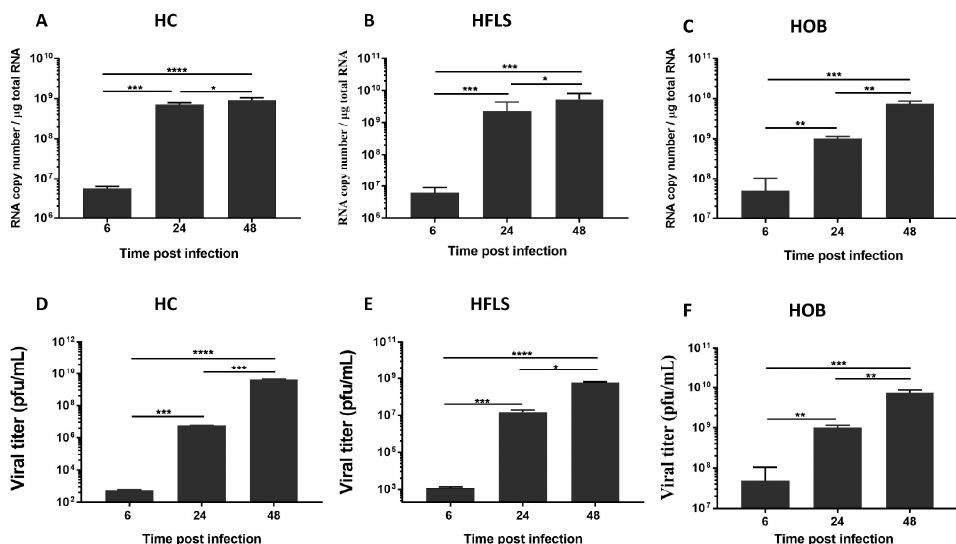
Figure 1. Human chondrocytes (HC), fibroblast-like synoviocytes (HFLS) and osteoblasts (HOB) are permissive to Mayaro virus (MAYV) infection. Cells were infected with MAYV at a multiplicity of infection (MOI) of 1. Viral RNA expression was then measured at 6, 24 and 48 h post-infection using real-time polymerase chain reaction (PCR) ( A – C ). Plaque assay analysis of culture supernatants of MAYV-infected cells were used to detect infectious viral particles ( D – F ). Experiments were performed three times each in triplicate (error bars represent standard errors of the means [SEM]). Comparisons between the indicated time point post infection were performed using one-way analysis of variance (ANOVA) and Tukey’s multiple comparisons test with a P -value significant when * p < 0.05, ** p < 0.01, *** p < 0.001, **** p < 0.0001.